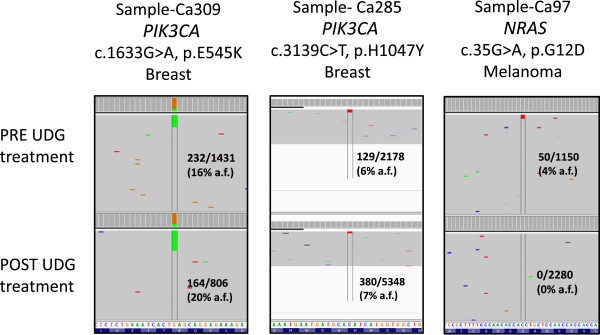
Uracil-DNA glycosylase treatment of FFPE DNA samples distinguishes true and false positive clinical relevant mutations. Integrative Genomic Viewer (IGV) screenshots of two breast cancers and one melanoma sample pre- and post- uracil-DNA glycosylase (UDG) treatment samples. The two breast cancer samples have confirmed PIK3CA mutations (E545K for Ca309 and H1047Y for Ca285) as these mutations were still detected after UDG treatment. The NRAS G12D mutation identified in the pre-UDG sample (Ca97) was a false positive as it was not present after UDG treatment. The variant reads over the total reads and overall allele frequency (a.f.) are shown for each case.